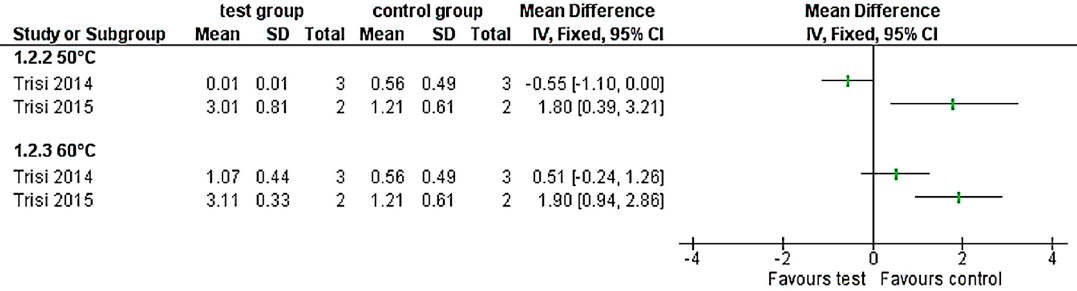
Figure 3. Forest-plots of the infrabony pockets (mm) around the implants that were thermally treated (50 °C and 60 °C) compared with the control group.